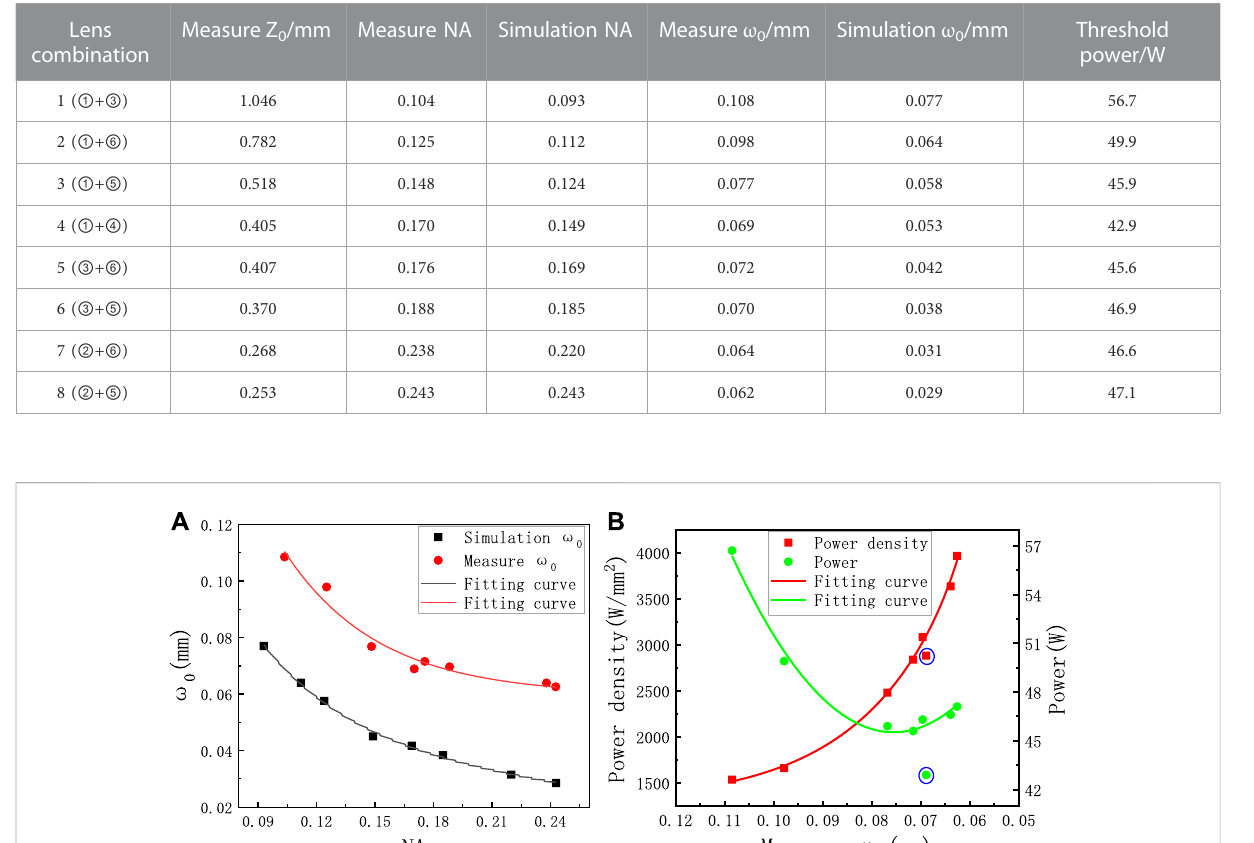
TABLE 1 Simulation and fi tting parameters of the focused beam with different lens combinations.